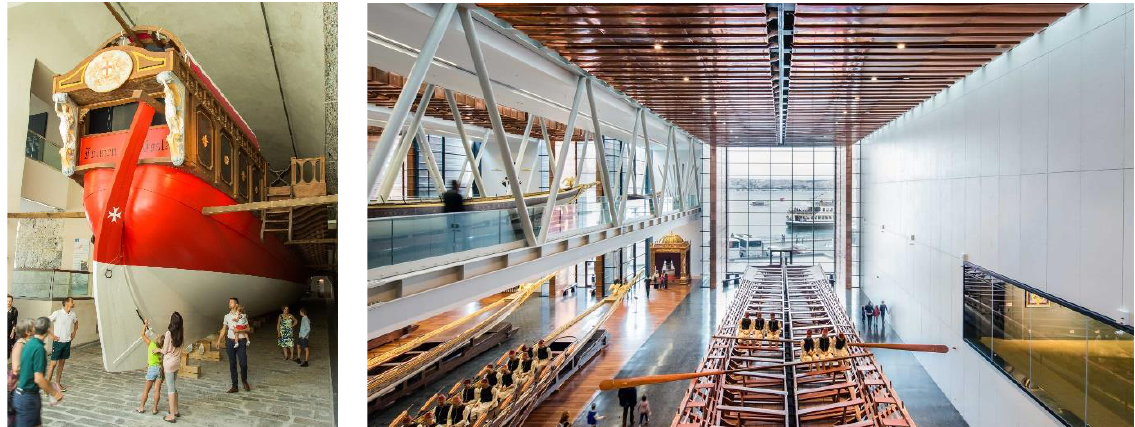
Figure 12 (left) Genova Galata Museo Del Mare’s view from the emergency exit (URL-4), Figure 13 (right) İstanbul Deniz Müzesi’s view from main entrance hall to emergency exit